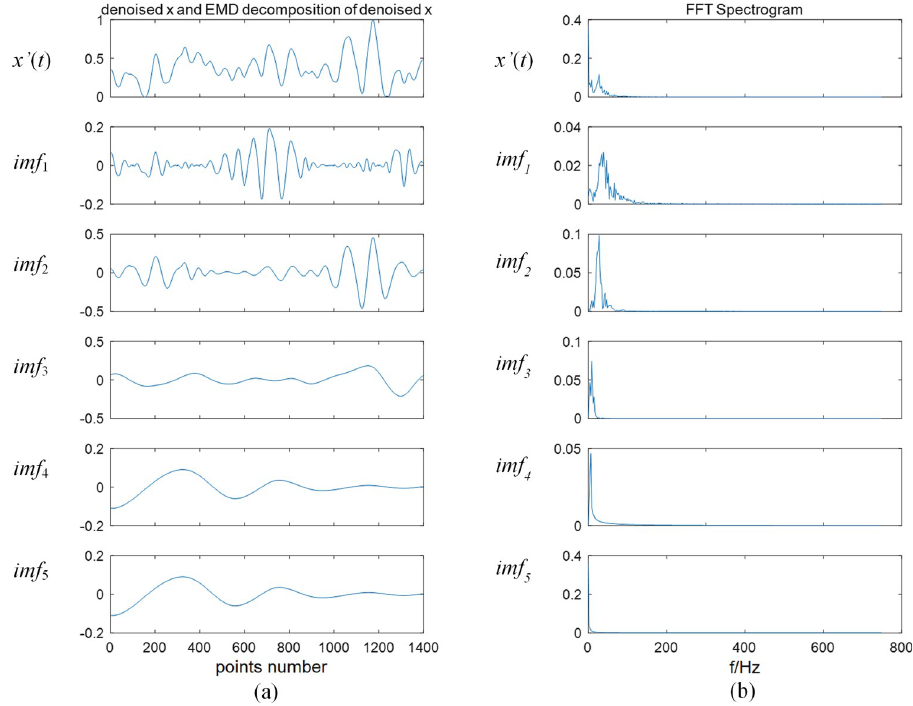
Fig 4. Results of denoising and signal processing. (a) Denoised biceps brachii signal x’ ( t ) and its IMFs in the time- domain. (b) Corresponding frequency distribution of x’ ( t ) and the IMFs after applying FFT method.